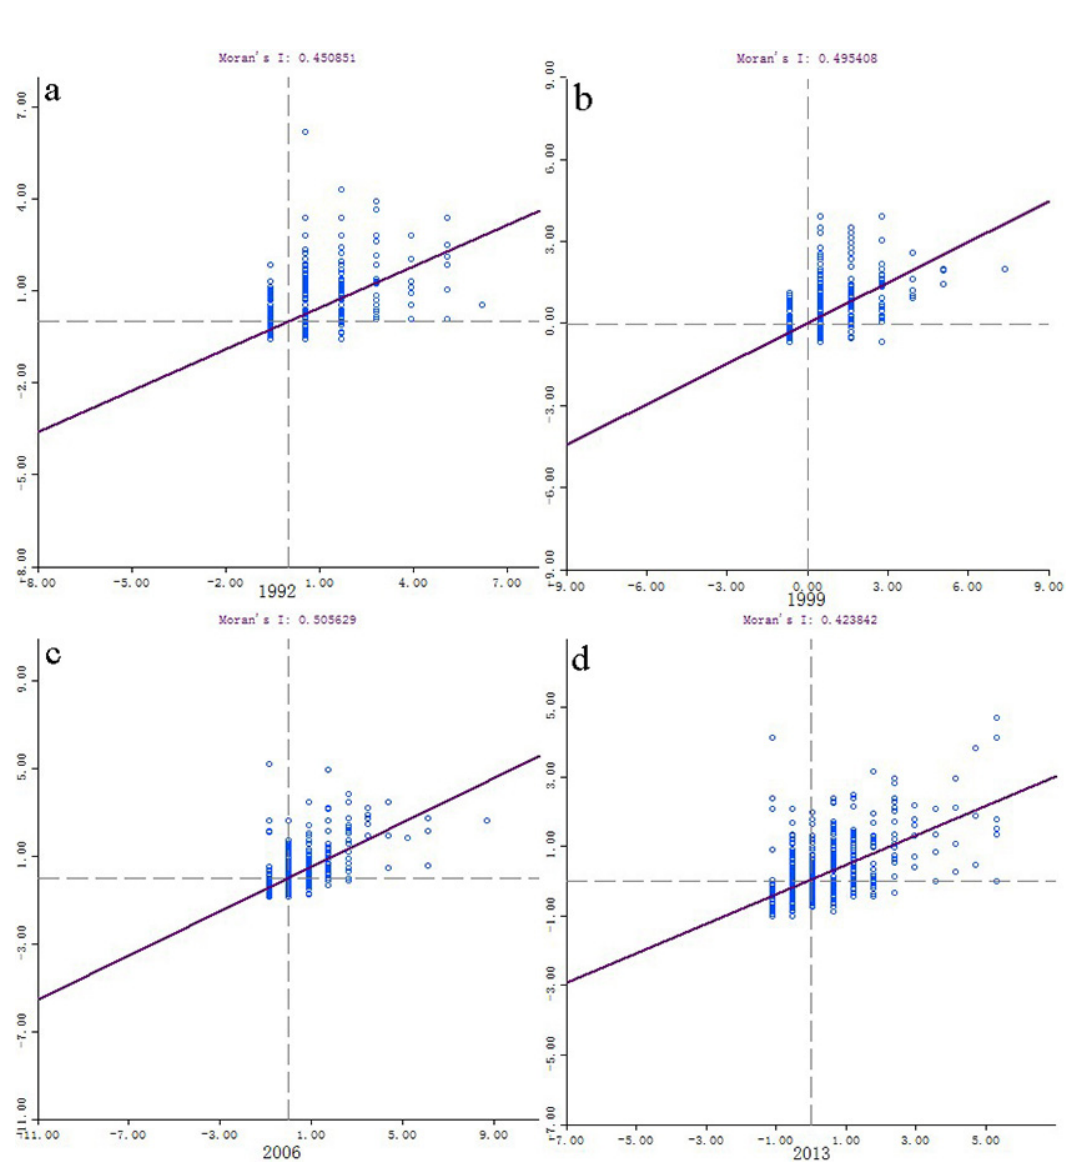
Figure 7. Scatter plot of the Moran’s I index in the urban expansion of the YREB in 1992, 1999, 2006, and 2013. ( a ) Scatter plot of the Moran’s Index of the YREB’s urban land expansion in 1992, ( b ) Scatter plot of the Moran’s Index of the YREB’s urban land expansion in 1999, ( c ) Scatter plot of the Moran’s Index of the YREB’s urban land expansion in 2006, ( d ) Scatter plot of the Moran’s Index of the YREB’s urban land expansion in 2013.